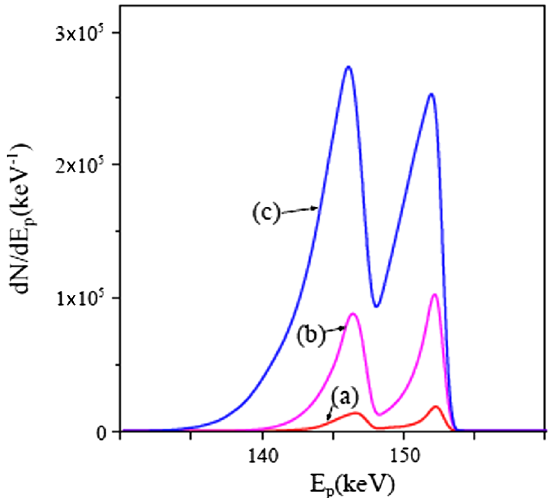
FIG. 7. Photon energy distance δ E p ¼ h j ν p; 1 − ν p; 2 j of the two peaks in keVas a function of the energy gap δ E e between the two electron beamlets in